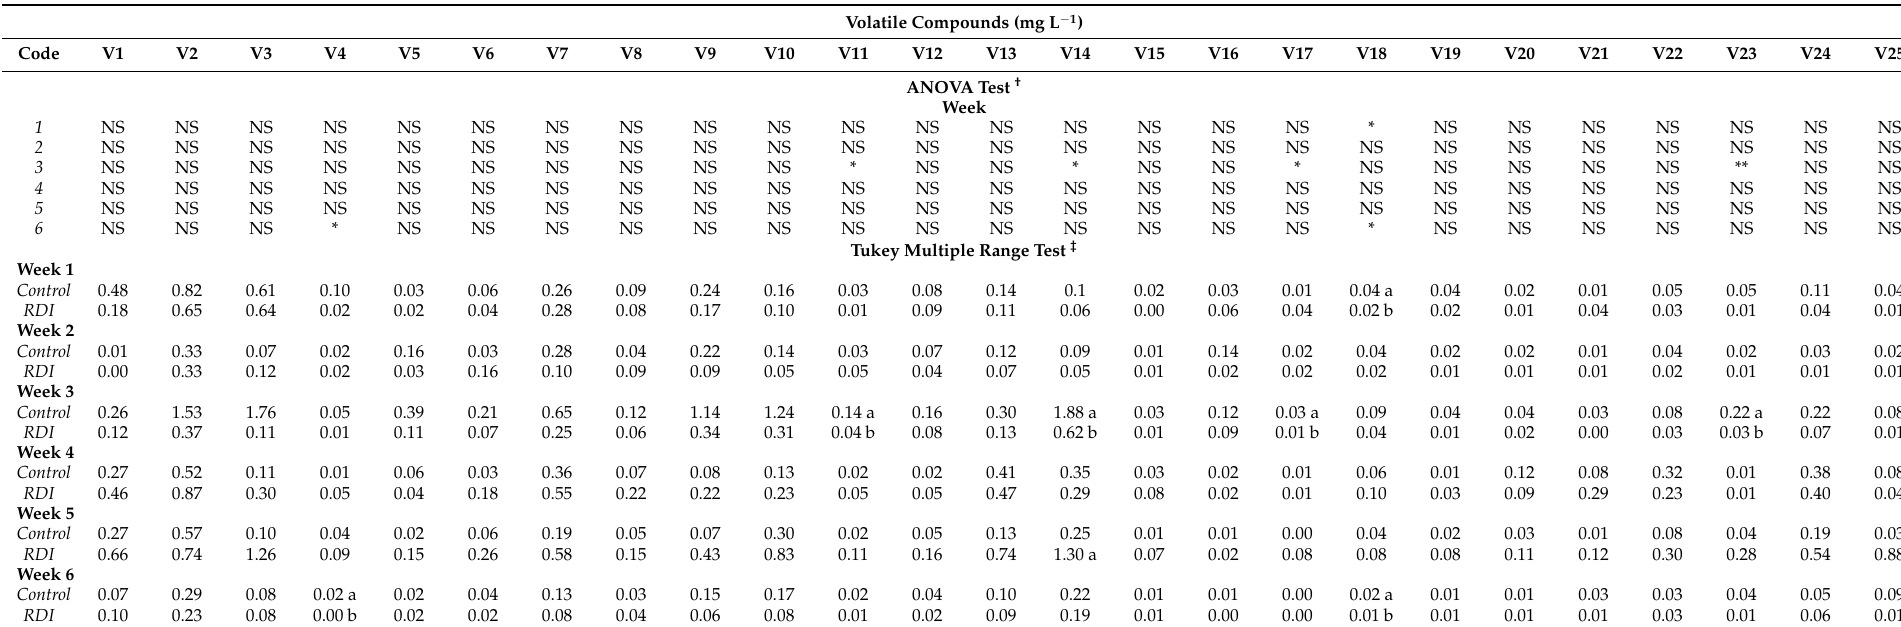
Table 6. Volatile compounds present in the cherry tomato